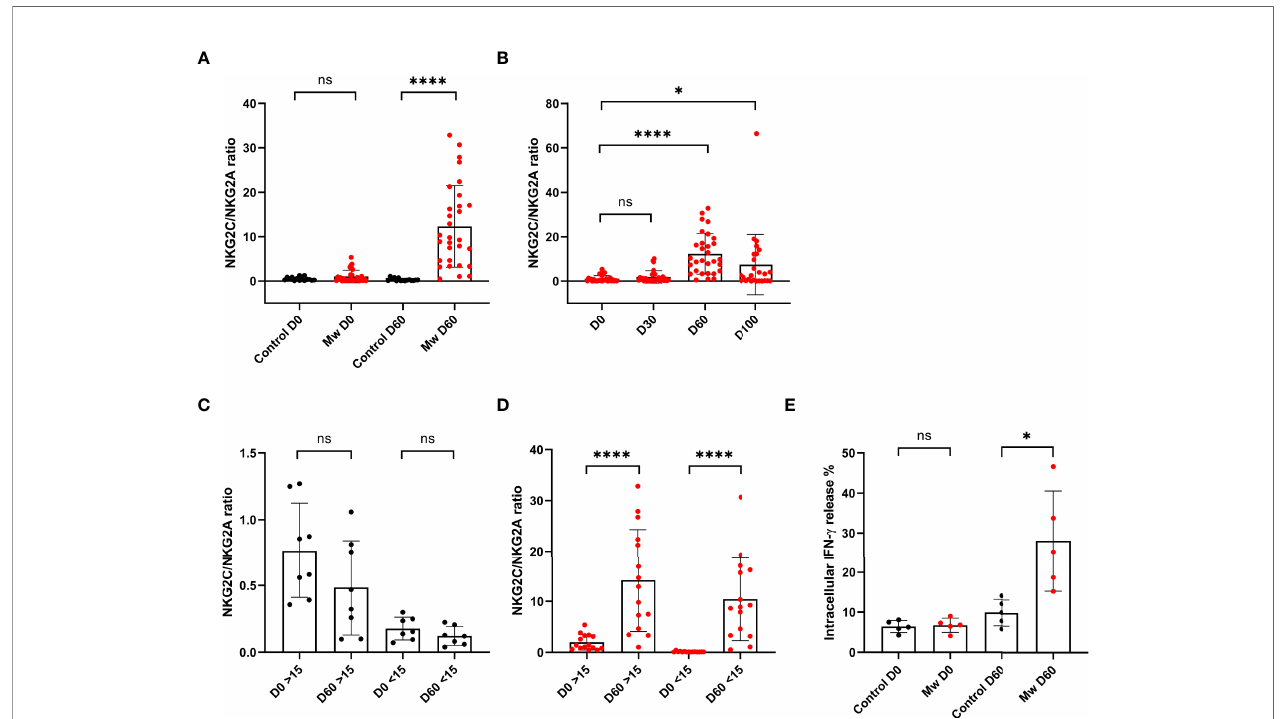
FIGURE 5 | Mw showed sustained effect on NKG2C/NKG2A ratios until 100 days and Impact of Mw intracellular cytokine (IFN- g ) release: Scatter dot with bar plot showing (A) NKG2C/NKG2A ratio of control group (n=15) and Mw group (n=30) at baseline and day 60. (B) Kinetics of NKG2C/NKG2A ratio at baseline, days 30, 60, and 100 in Mw group. (C, D) Kinetics of NKG2C/NKG2A ratio at baseline and day 60 on the basis of >/< 15% NKG2C at baseline in Mw group and control group, respectively. (E) intracellular IFN- g release in both control (n=5) and Mw (n=5) groups at baseline and day 60. Red and black shaded circles represent Mw group and control group, respectively. ****p < 0.0001, *p < 0.05 and ns, p-value not signi fi cant.